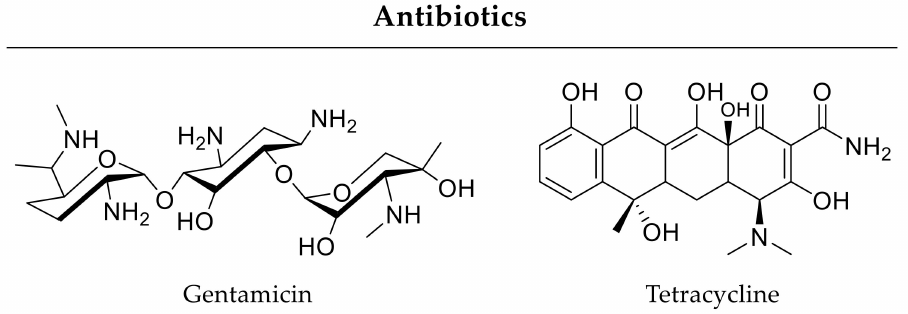
Figure 9. Chemical structures of selected antibiotics. Gentamicin prevents bone infections, whereas tetracycline inhibits osteoclast di ff erentiation and displays a high a ffi nity to bone minerals as